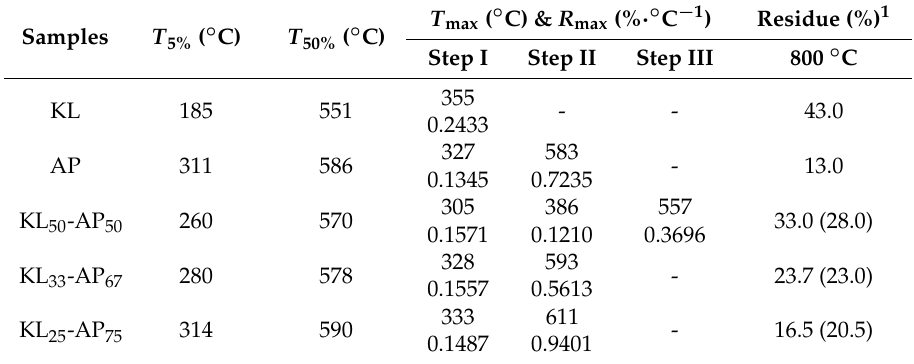
Figure 1. TG and DTG curves of KL, AP, and their blends. Table 2. TGA results of lignin, ammonium polyphosphate and their respective blends under nitrogen